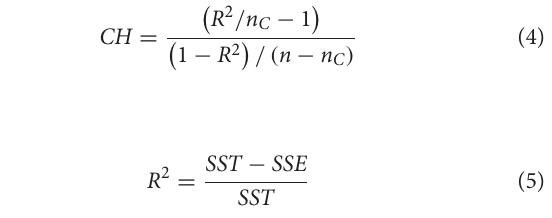
at 11.5742 ◦ N, 37.3614 ◦ E, and Nekemte at 9.0893 ◦ N, 36.5554